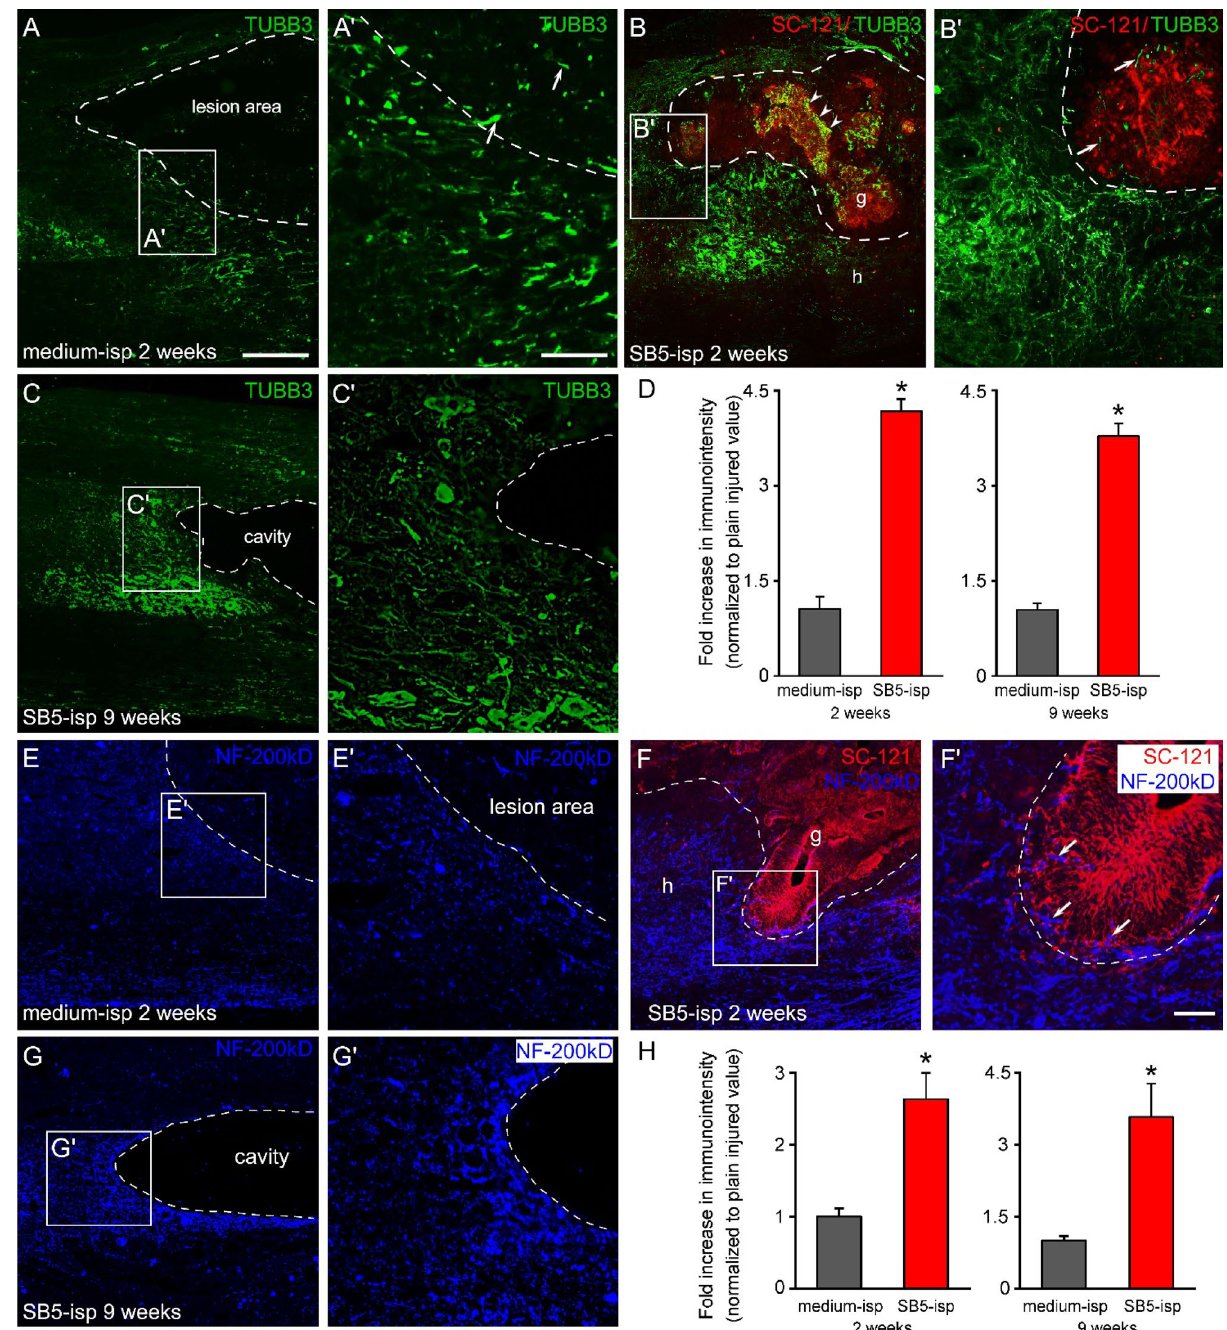
Figure 9. Increased TUBB3 immunoreactivity around the grafted area. ( A – B ) Representative images of TUBB3- positive host neurites in the control and grafted groups ( medium-isp and SB5-isp ) at the rostral part of the affected segment 2 weeks after the injury. ( A ′ ) TUBB3-positive host neurites tended to approach the lesion area in the control animal ( medium-isp ). ( B ′ ) TUBB3-positive host neurites display robust plasticity around and within the grafted area 1 week after hiPSC transplantation ( SB5-isp ). ( C ) A lesser extent of plasticity of TUBB3-positive host neurites was observed at 9 weeks after the injury in the grafted group ( SB5-isp ). ( D ) Quantification of TUBB3 immunointensity in the paramedian sagittal sections of the spinal cord revealed an increased level of immunoreactivity in hiPSC-treated group 2 and 9 weeks after the injury compared with the control group. ( E , E ′ ) Confocal images show NF-200kD- positive axons in the control group ( medium-isp ) 2 weeks after the injury. ( F , F ′ ) Numerous NF-200kD-positive host axons reached outside boundary of the graft. Quantification of NF-200 immunoreactivity demonstrated a significant increase in NF-200kD immunodensity in the grafted group 2 and 9 weeks after injury. Data are expressed as mean ± SEM. (n = 4 in both of the groups) *significant difference between the intraspinally ( SB5-isp ) with the control ( medium-isp ) animals in D and H. Dashed line indicates the lesion area/cavity area and spared tissue in ( A , A ′ , C , C ′ , E , E ′ , G , G ′ or the graft-host border in ( B , B ′ , F , F ′ ). Arrows show TUBB3-positive host neurites (in A ′ and B ′ ) and NF-200kD-positive host axons (in F ′ ). Arrowheads point to TUBB3-positive grafted cells in B. g, graft; h, host; Scale bars: A: 200 µm, (A ′ ) 100 µm, (F ′ ) 30